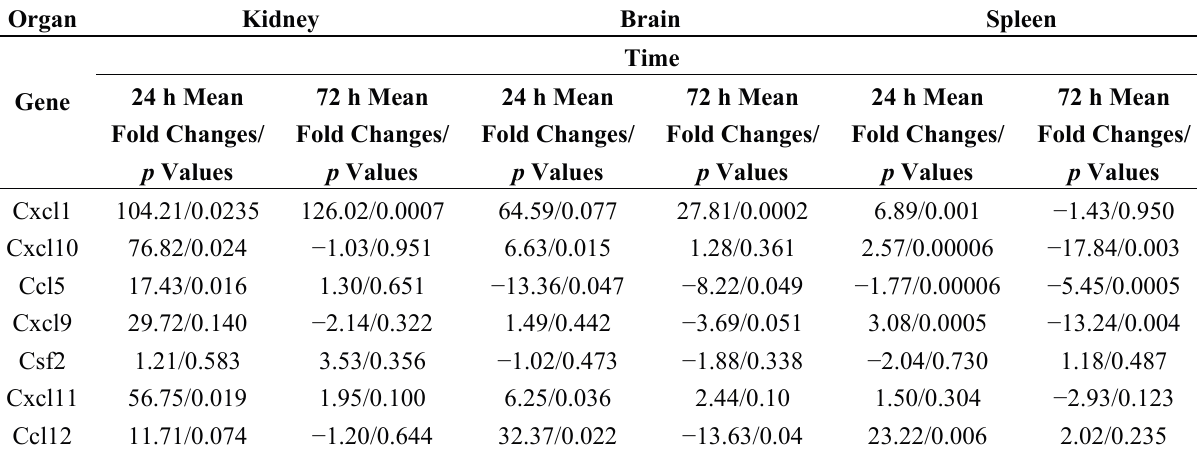
Table 3. The fold changes of chemokine genes in whole kidney, spleen and brain towards systemic C. albicans infection at 24 and 72 h post-infection. The fold changes were calculated based on the normalization of the target gene to the reference genes, β -actin, GAPDH, 18s ribosomal RNA and beta-2 microglobulin using the ΔΔ C mice as compared to that in uninfected mice. Results were means of fold changes of three biological replicates and highlighted parts are the genes which were statistically significant at p < 0.05 as compared with uninfected group,